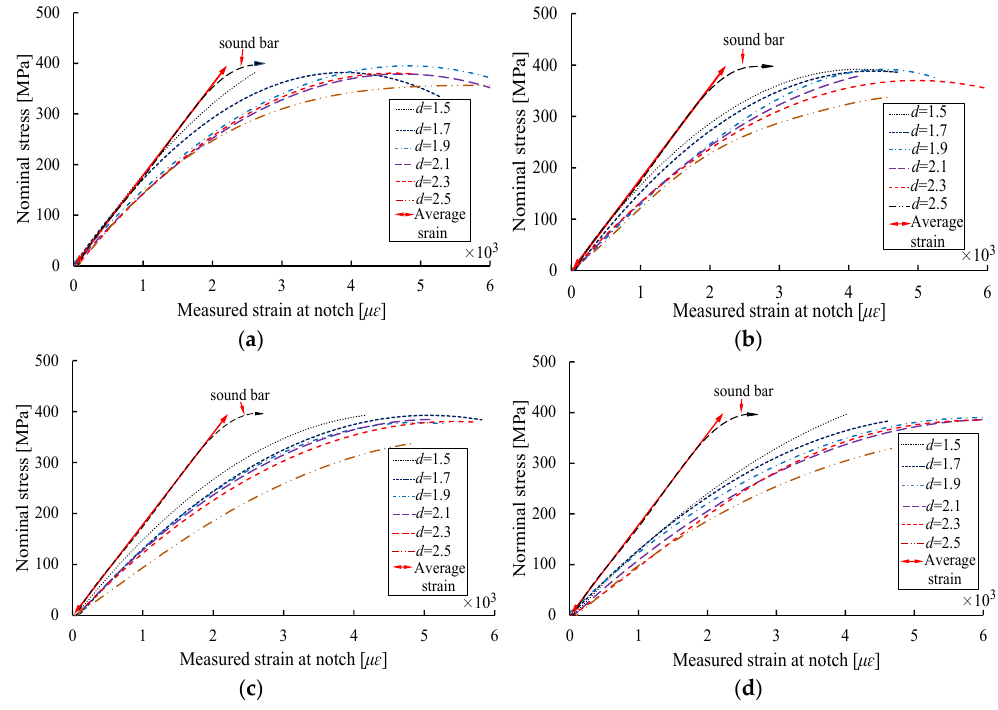
Figure 4. Stress-strain curves of specimens with different notch depths. ( a ) Axial ellipse; ( b ) radial ellipse; ( c ) length-variable triangle; ( d ) triangle.